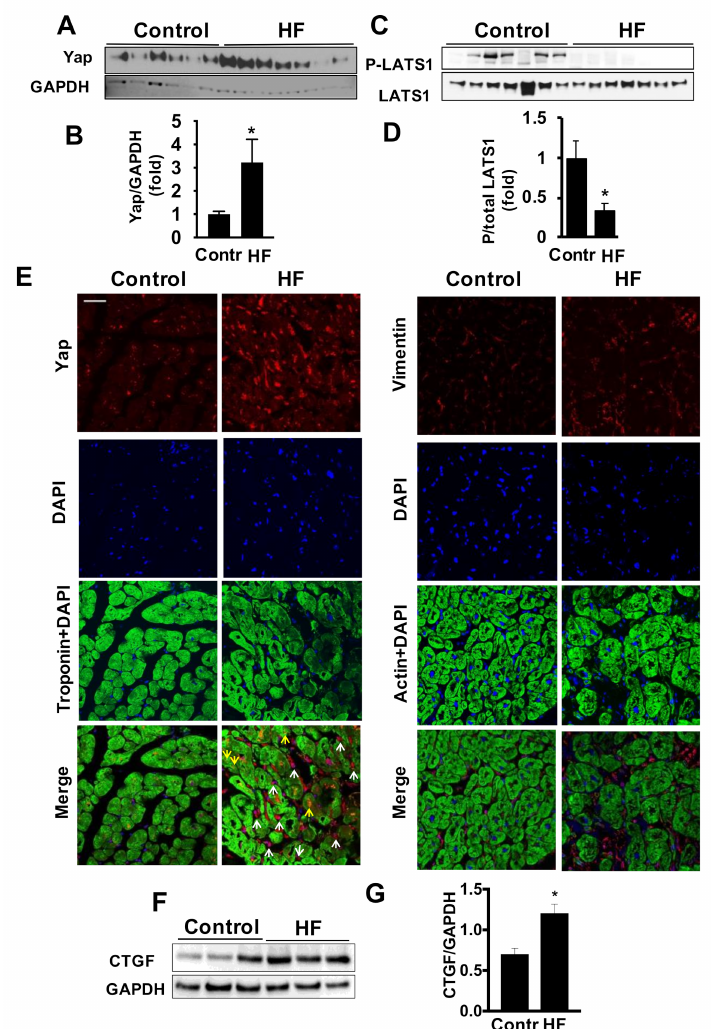
Figure 1. HIPPO signaling is dysregulated in LV of HF patients. ( A , C , F ) LV tissues from non- failing subjects (control) and patients with HF (non-ischemic, male, Caucasian) were subjected to immunoblot analysis to detect indicated total or phosphorylated (P) protein levels. ( B , D , G ) Graphs presenting fold change quantitative densitometry analysis of indicated proteins normalized to corresponding loading or total-protein control. Data represents fold changes from control. Data are mean ± S.E.M from 6–9 subjects/group. * p < 0.05. ( E ) Immunofluorescent staining analysis of